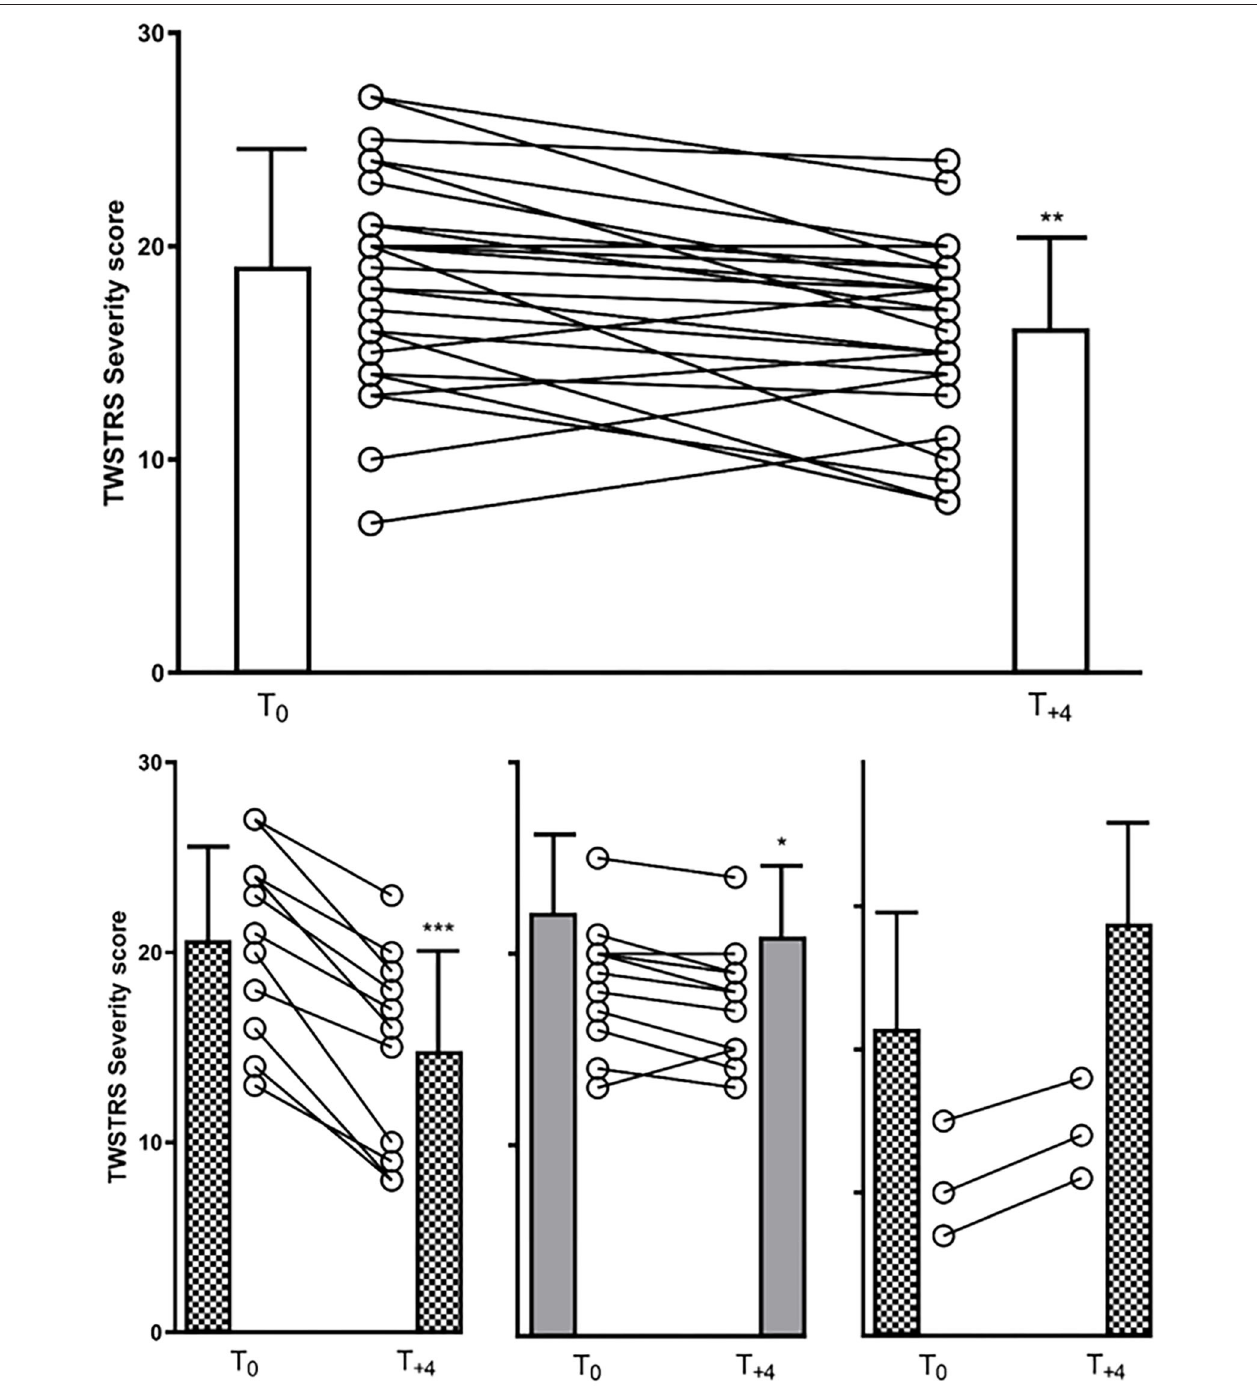
FIGURE 3 | (upper part): TWSTRS severity subscore of the entire cohort at baseline and week 48 (12 weeks after the last of four incoBoNT/A injections). Mean values with corresponding SDs and individual data of 25 patients are shown. T0 = baseline TWSTRS severity score just before first incoBoNT/A treatment; T + 4 = TWSTRS severity score 12 weeks after 4th incoBoNT/A treatment. (lower part): Similar presentation as in the upper part for the responder group (left side), the possible responder group (middle part) and the non-responder group (right part). * P < 0.05; ** P < 0.01; *** P < 0.001.